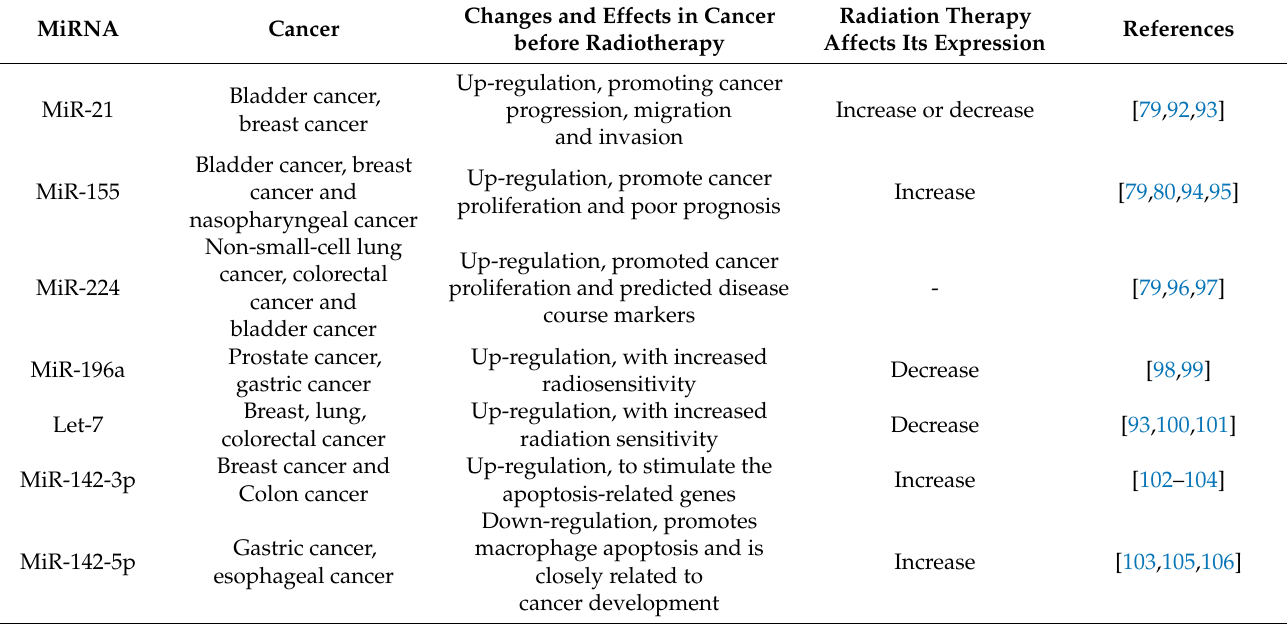
Table 1. The effect of different types of miRNA on cancer and the effect of radiotherapy on